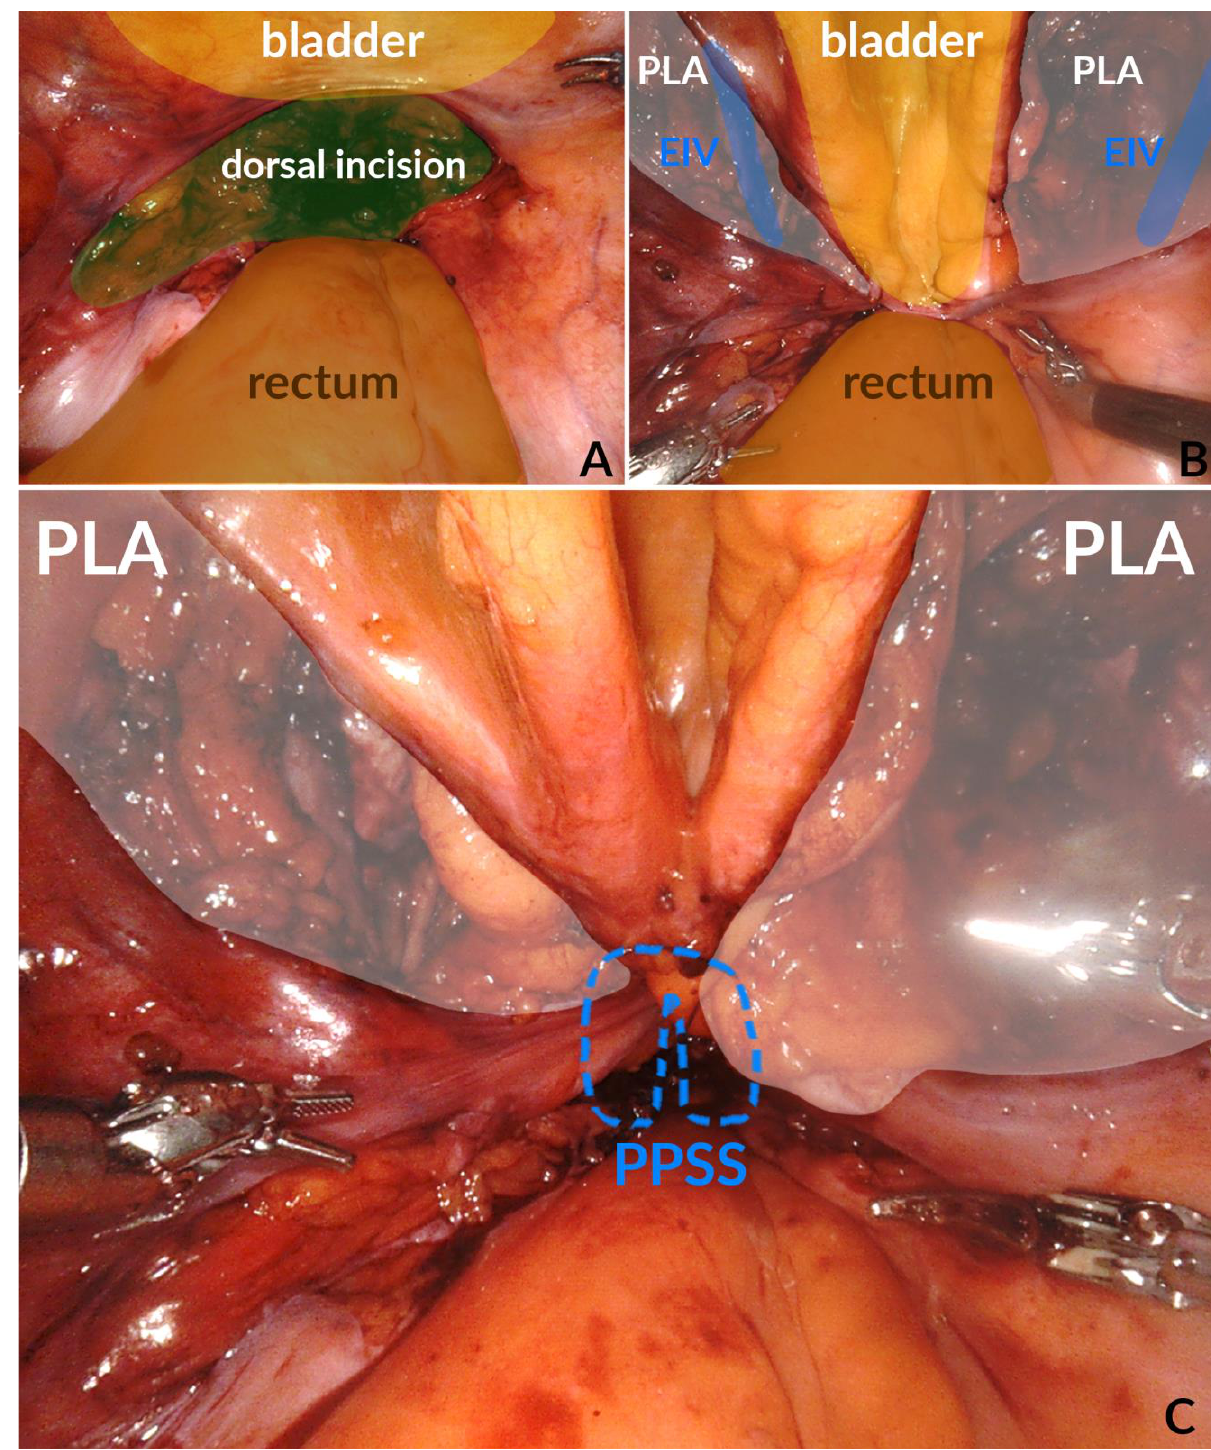
Figure 1. ( A ) Subtrigonal access to the prostatic bed through dorsal incision; ( B ) iliac fossa with pelvic lymphadenectomy on both sides; ( C ) opening of the iliac fossa on both sides and closure of the dorsal incision through a peritoneal purse-string suture. Abbreviations: PPSS: peritoneal purse string suture, EIV: external iliac vein, PLA: pelvic lymphadenectomy.